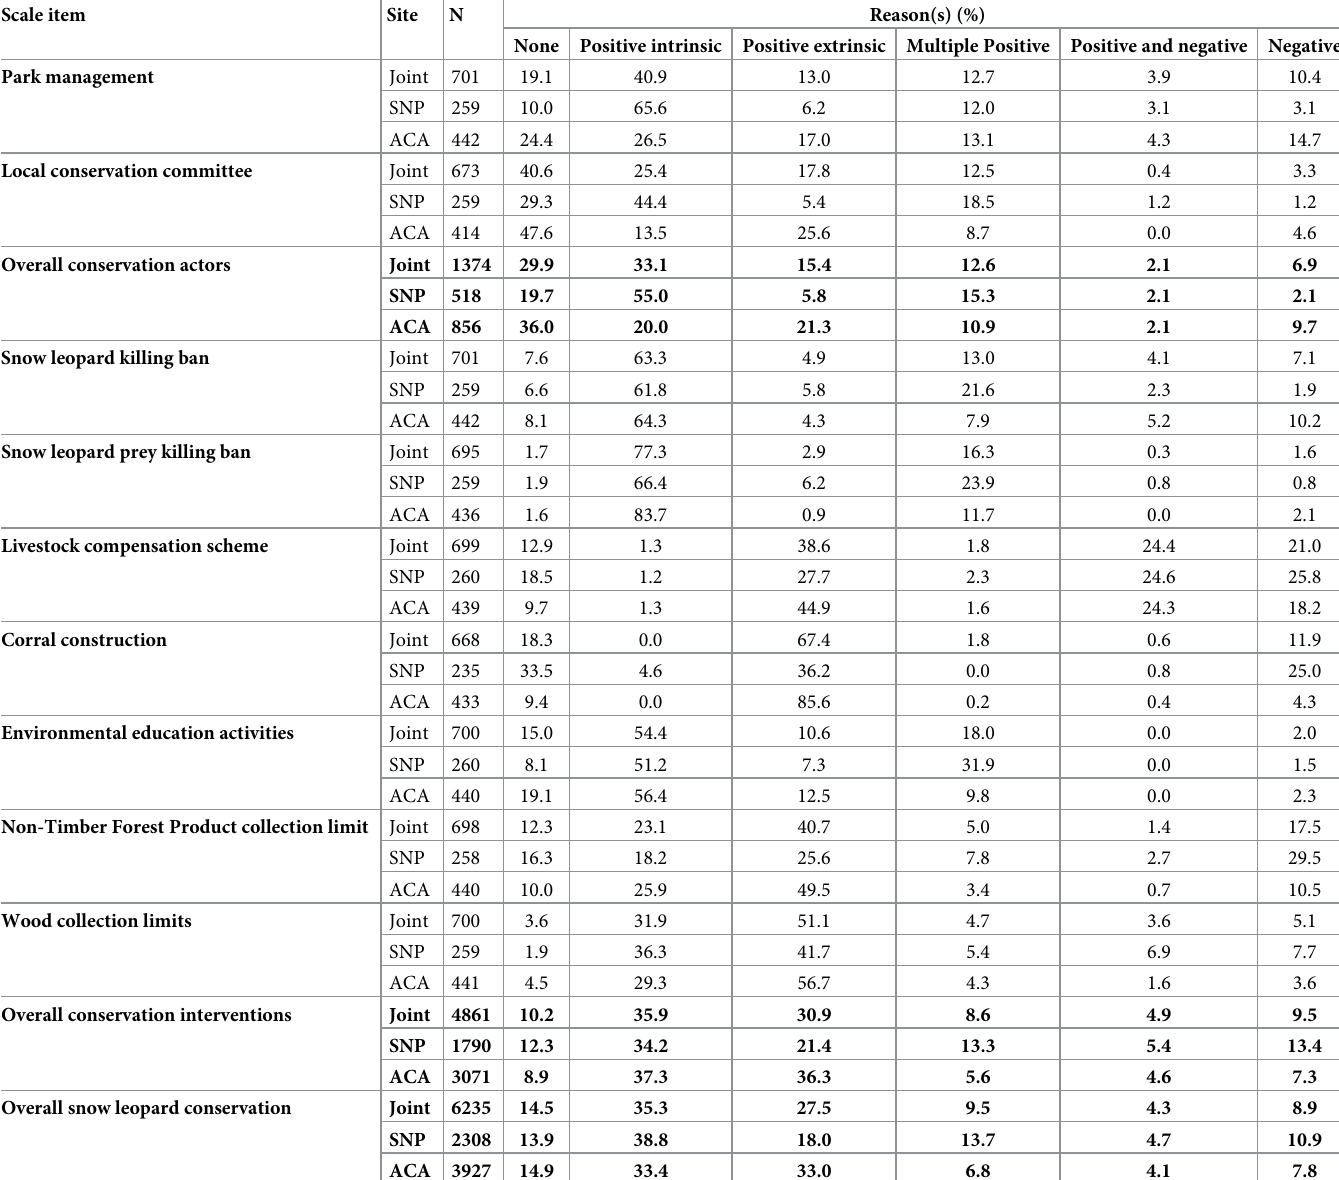
Table 5. Factors best explaining attitudes to snow leopard conservation for a combined sample, in Sagarmatha National Park (SNP) and Annapurna Conservation Area (ACA). Scale item Site N